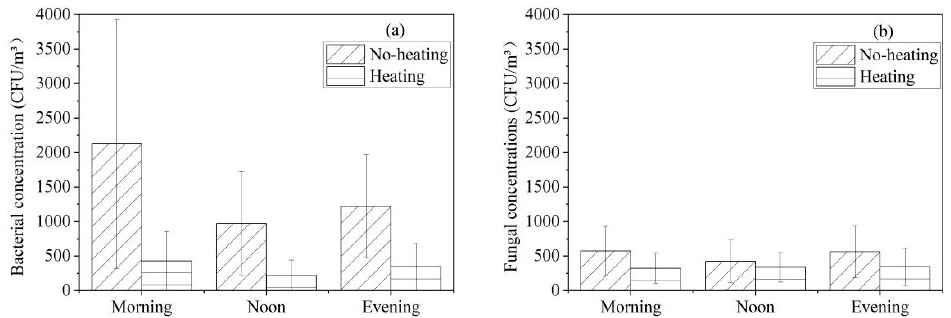
Figure 4. Culturable airborne bacteria and fungi during the unheated and heated periods: ( a ) bacteria; ( b ) fungi.